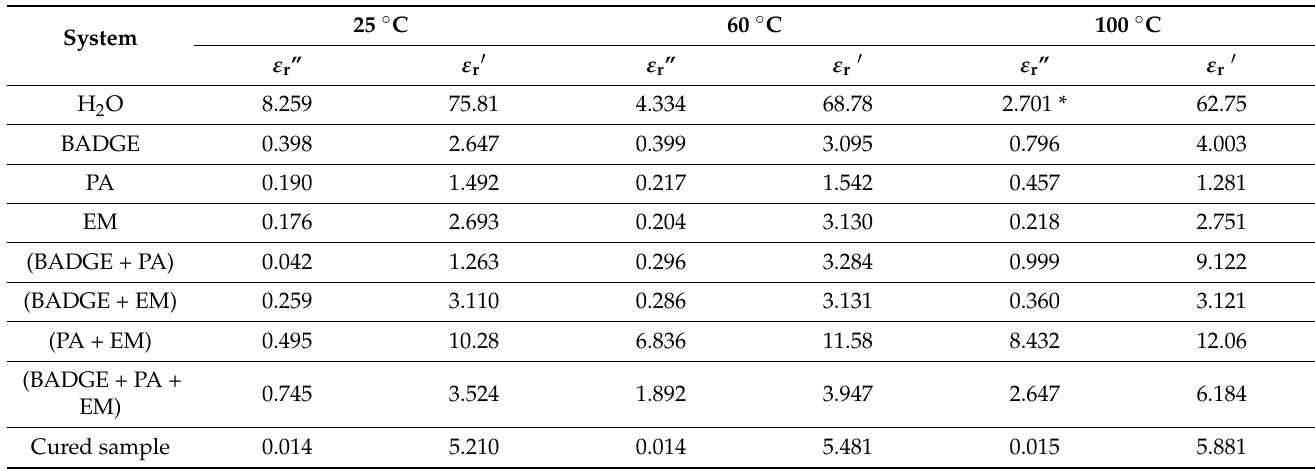
Table 2. Relative dielectric loss ( ε r ”) and relative dielectric factor ( ε r (cid:48) ) of each component of the adhesive (BADGE + PA + EM) mixture and other mixtures, together with that of ion-exchanged water (H 2